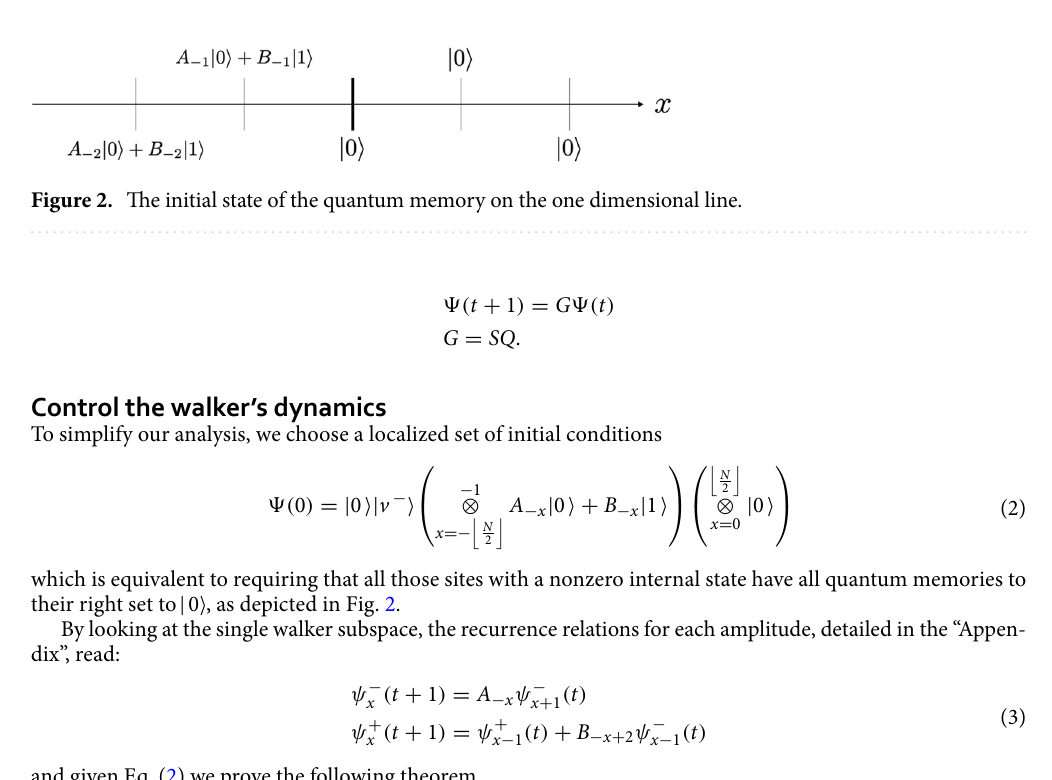
Figure 1. Schematic evolution of the walker � x ( 0 ) at the initial time conditioned by the neighbors qubits at 1 and x 1 . position x = − =